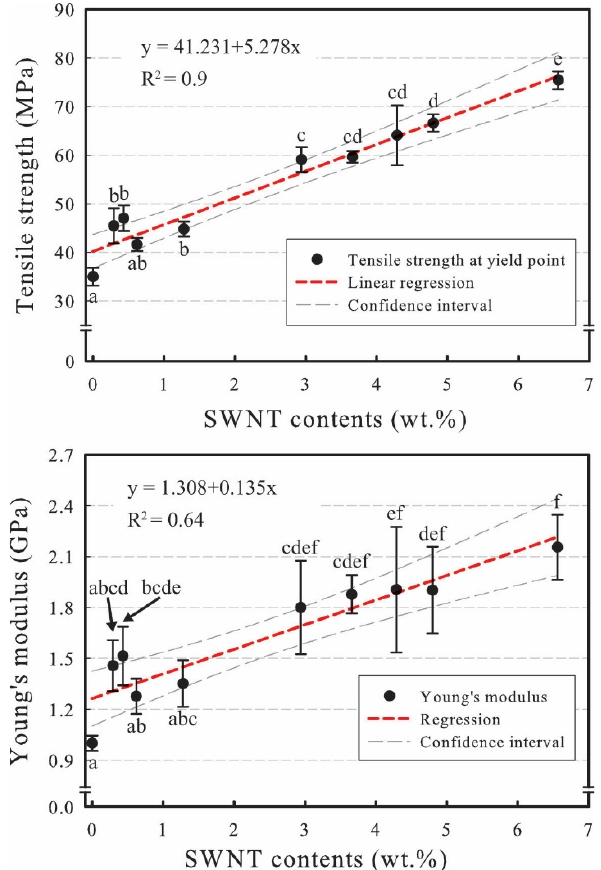
Figure 7. Tensile strength ( top ) and Young’s modulus ( bottom ) of the composites as a function of SWNT content; different letters on the top or bottom of the error bar indicate a statistically significant difference at the 95% confidence level.